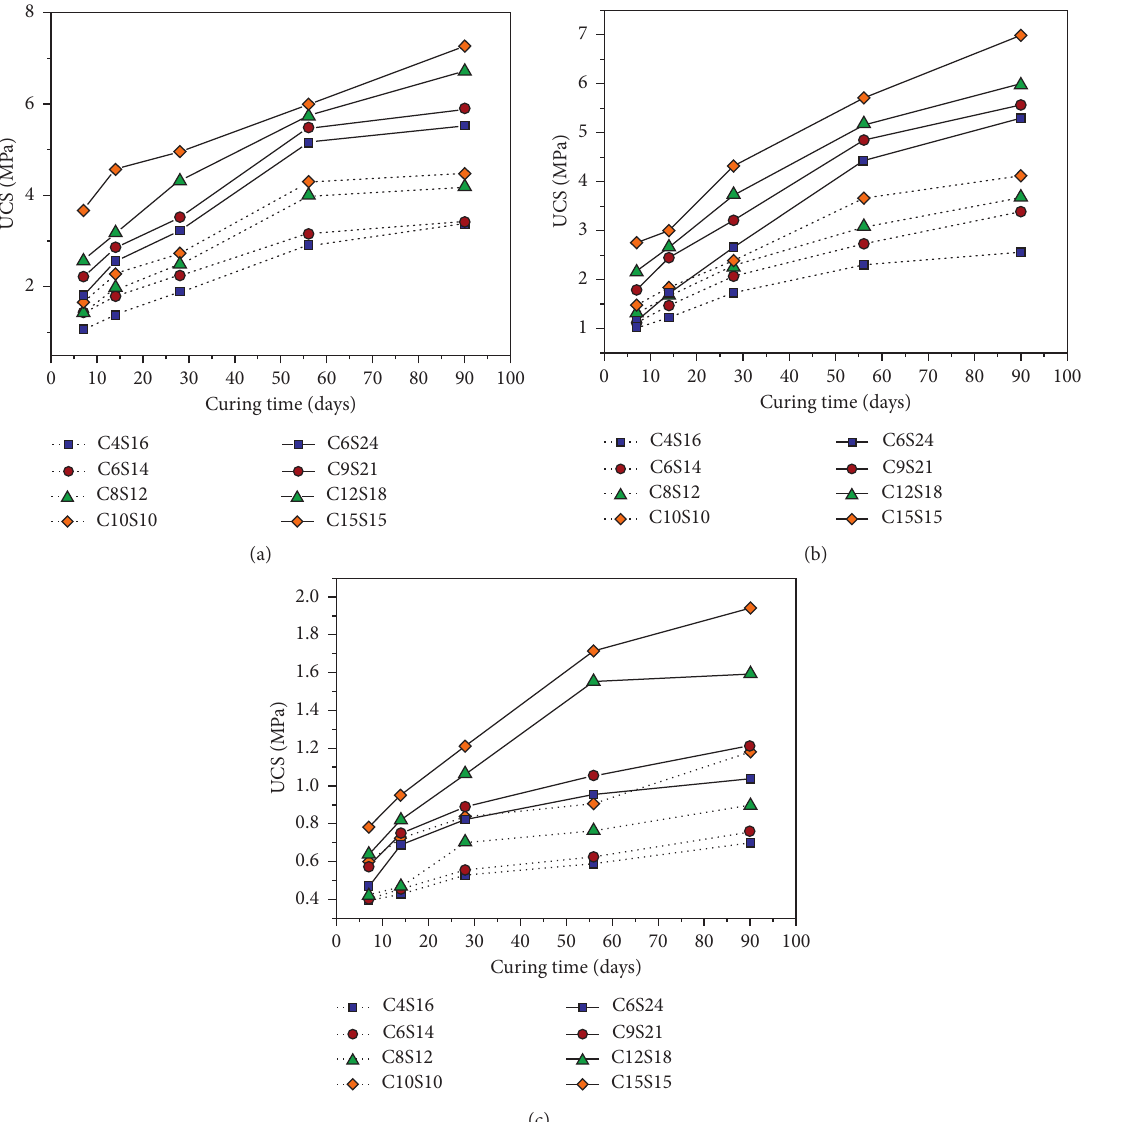
Figure 2: Evolutions of UCS with curing time of the stabilized Cr-contaminated soils: (a) Cr0.1, (b) Cr0.5, and (c)